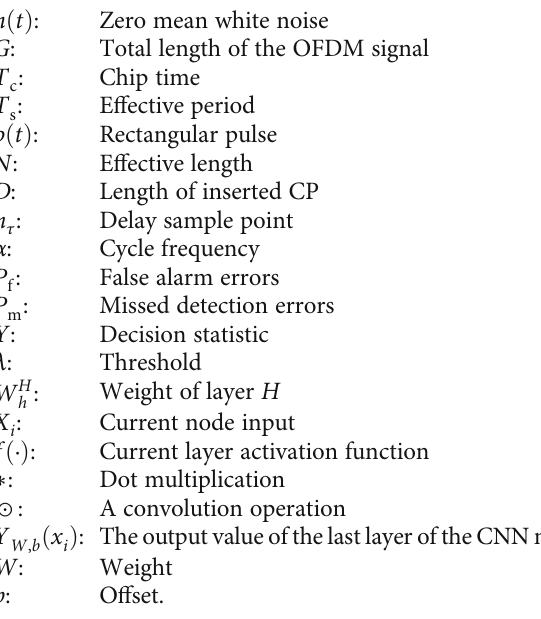
Figure 11: ROC curves of di ff erent spectral sensing methods P with P SNR = − 12dB f